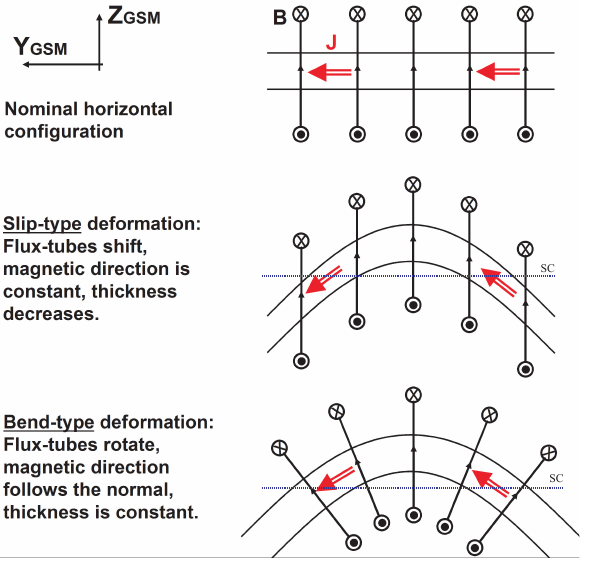
Fig. 20. Scenarios for cross-tail current sheet deformations. The view in the YZ GSM plane is shown, assuming nominal configu- ration with B y =0. The blue dashed lines show spacecraft passes. (From Petrukovich et al.,